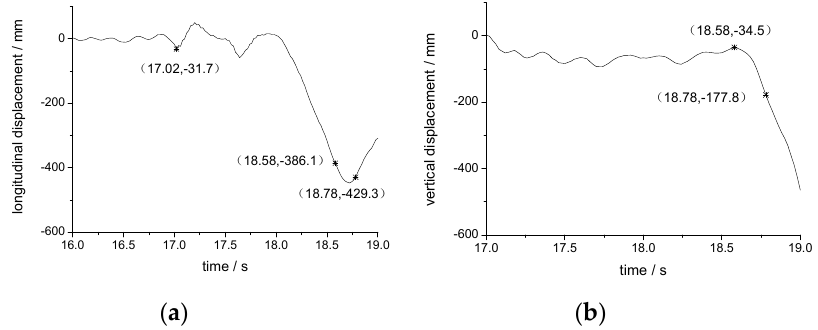
Figure 28. Time history curve of the top part of the middle pier: ( a ) longitudinal; ( b ) vertical.